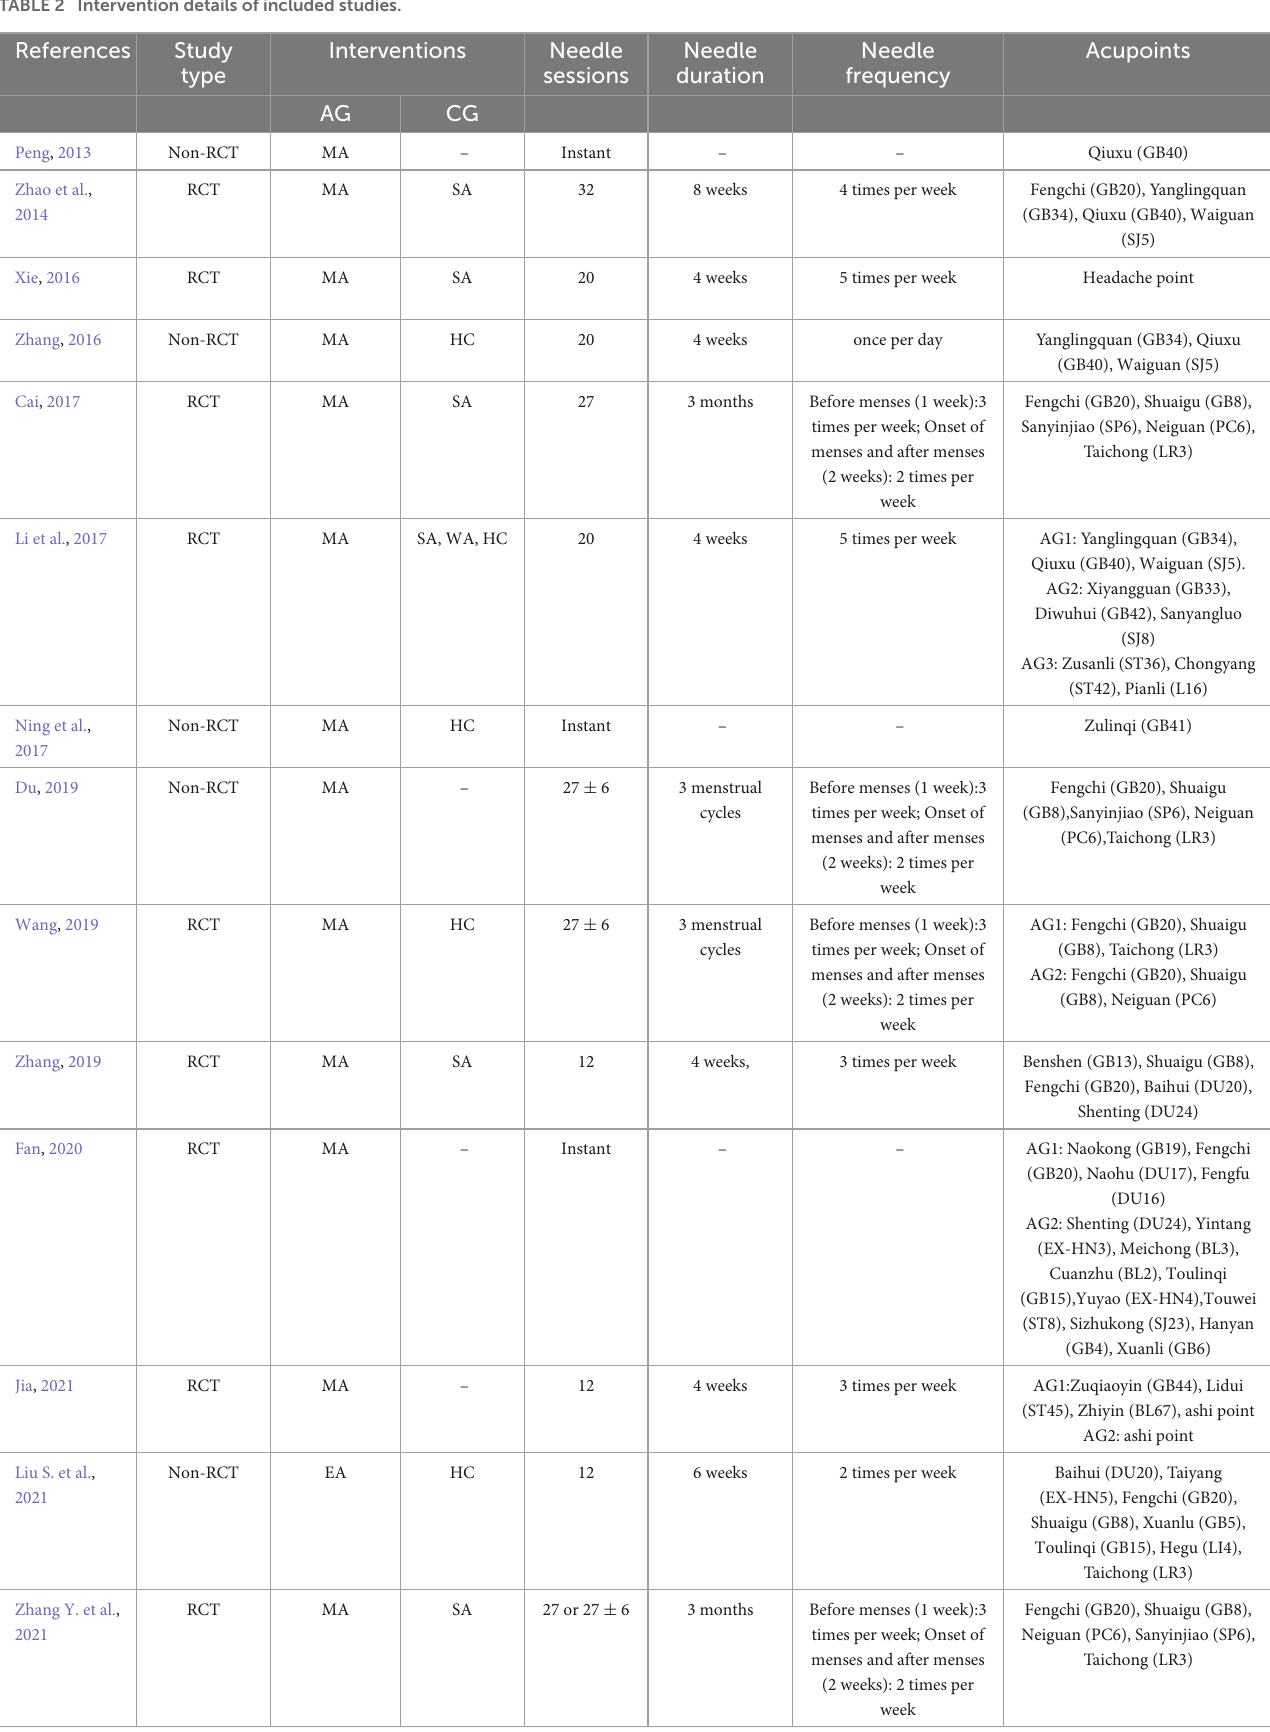
TABLE 2 Intervention details of included studies.